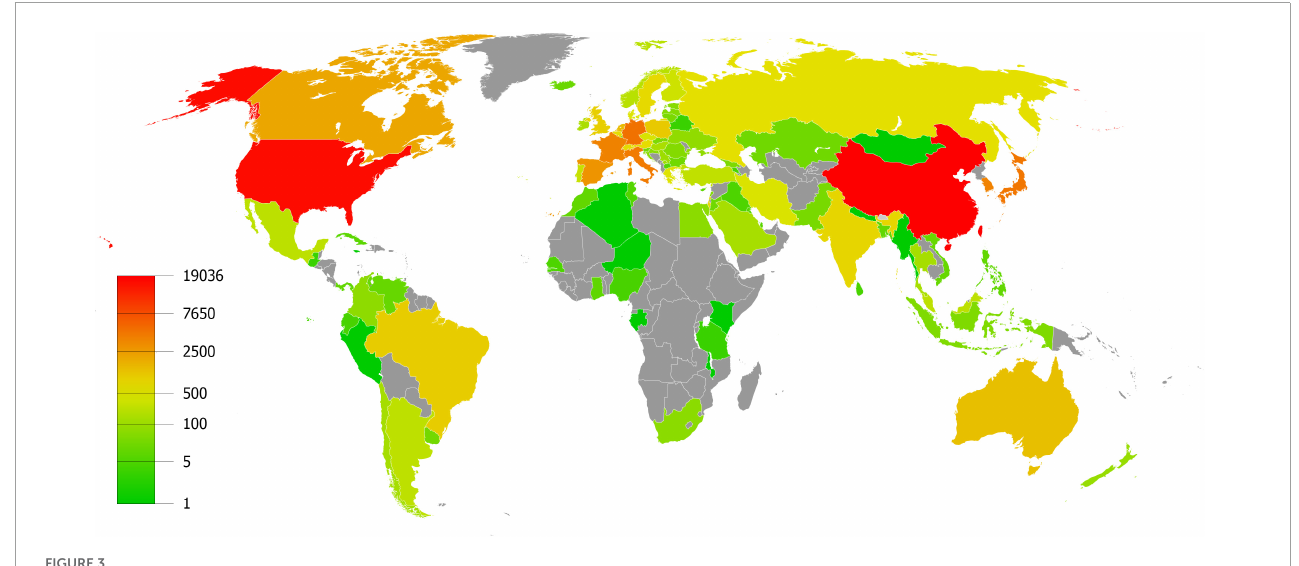
FIGURE3 Articles published per country/region.